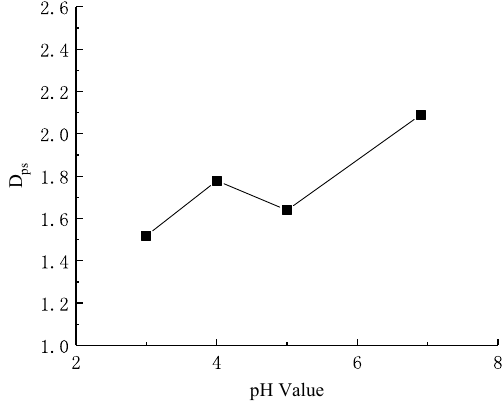
Figure 8. The D ps of loess samples under acid rain conditions.